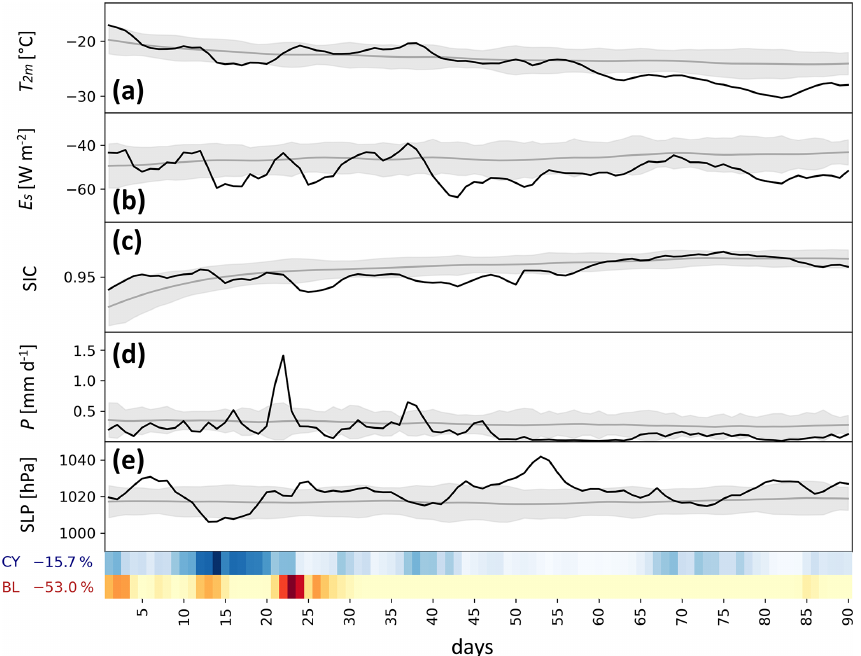
Figure 14. Same as Fig. 9 but averaged in sub-region ARI in DJF